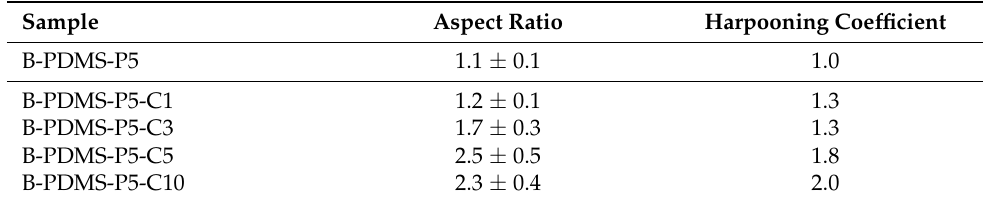
Table 2. Aspect ratio and harpooning coefficient of some selected bulk compositions.